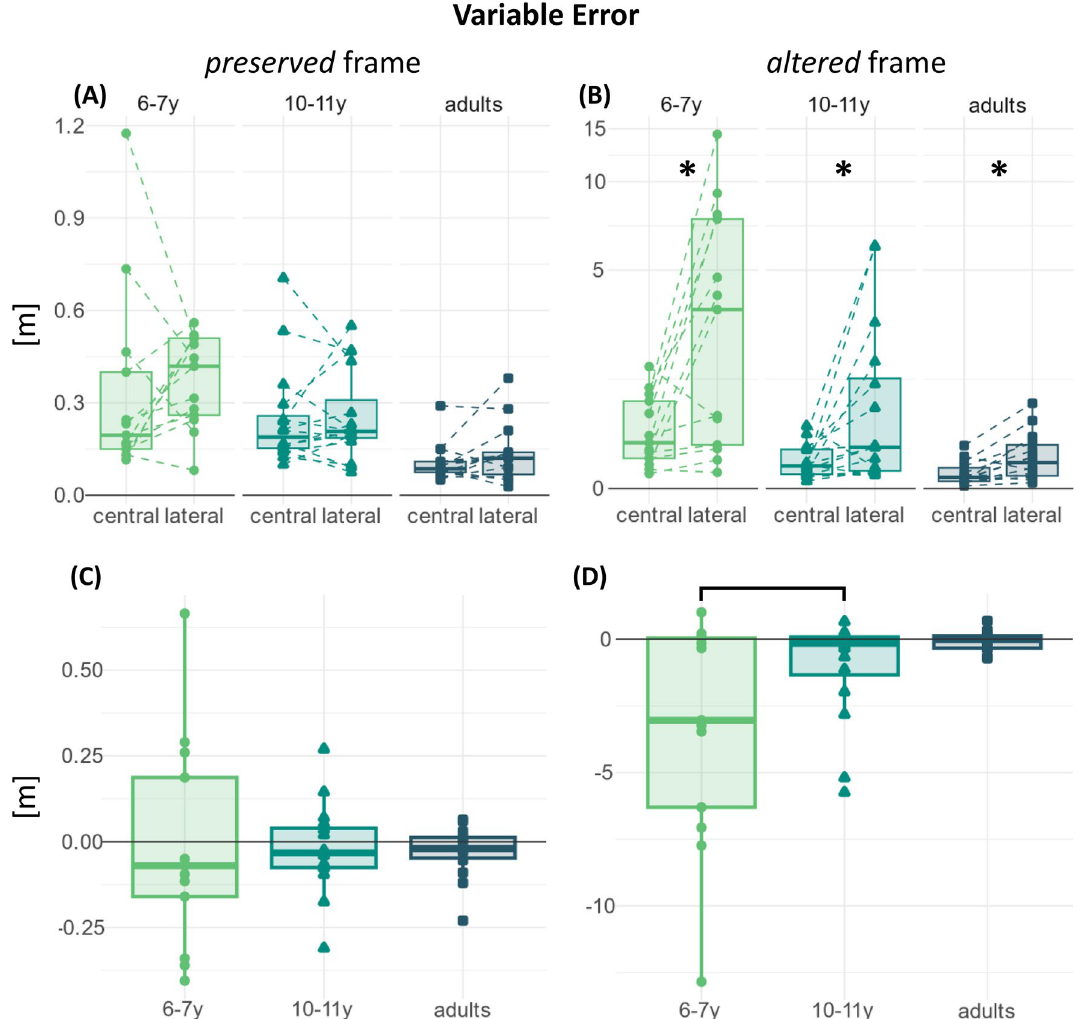
Figure 4. Raw ( A , B ) and differential ( C , D ) variable error distributions, split according to the “frame” factor levels: preserved ( A , C ) and altered ( B , D ). The y-axes in panels ( A ) and ( B ) are in the 10 0 magnitude scale. The y-axes in panels ( C ) and ( D ) are in the 10 1 magnitude scale, and they have been transformed in pseudo- logarithmic scale for the sake of data visualization clarity. The asterisks indicate the significant within-age comparisons. The bars indicate the significant between-age Altered “frame”. The follow-up mixed ANOVA reached significance in all the effects tested. The results are reported in Table 1. The permutation-based paired t-test reached significance in the 6–7-year-old group, t(12) 6–7 = 2.08, p = 0.026, r rb = 0.71, 95% CI [0.27, 0.91], and in the 10–11-year-old group, t(15) 10–11 = 1.70, p = 0.048, r rb = − 0.50, 95% CI [− 0.04, 0.81], while in the adult group it approached significance, t(13) adults = 2.04, p = 0.060, r rb = 0.50, 95% CI